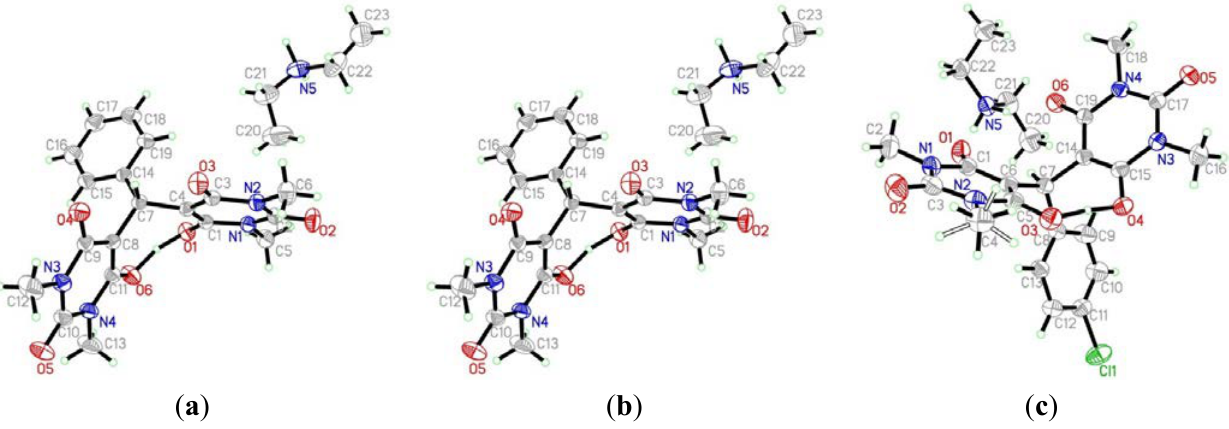
Figure 2. ORTEP representation of the structure of 3a – c .